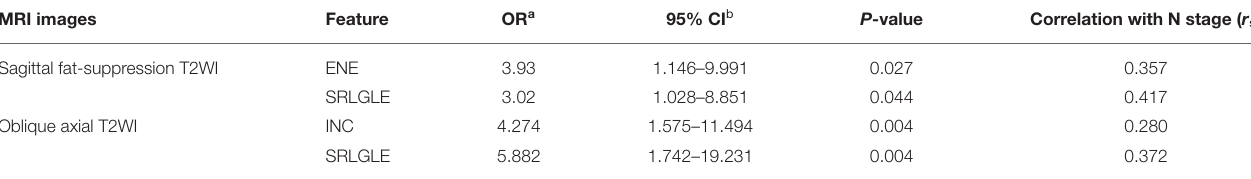
TABLE 5 | Multivariate logical regression analysis results.